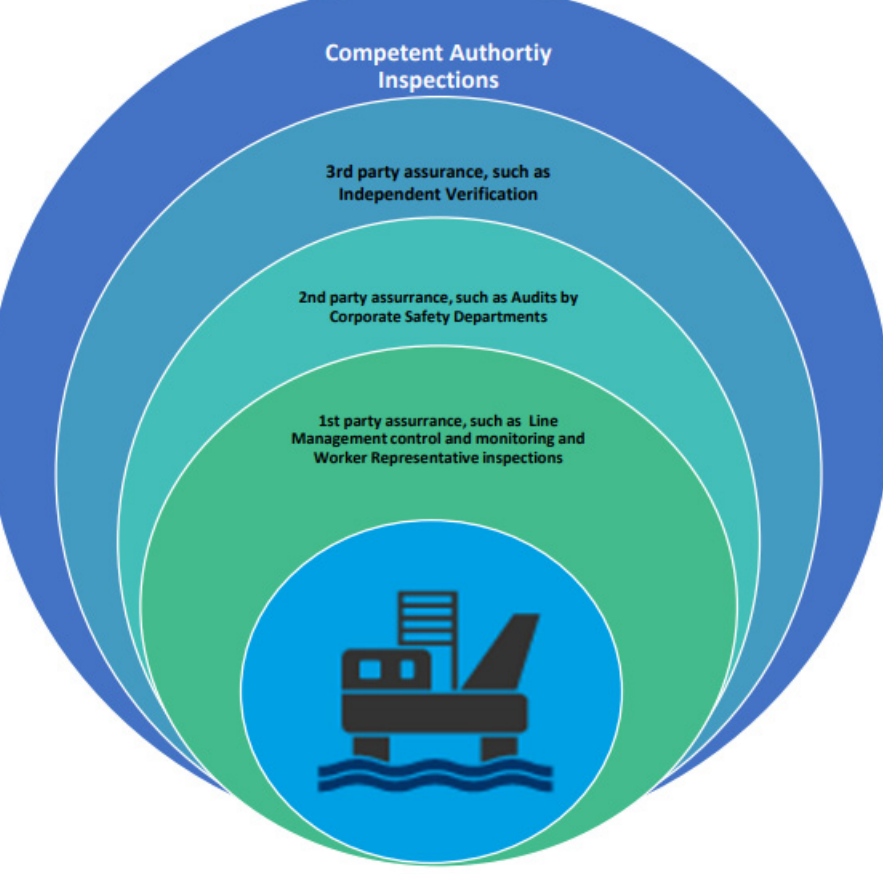
Figure 20. Assurance, monitoring, and assessment systems in the offshore oil & gas industry. (This image is re-used/reproduced with permission of the Health and Safety Executive under the terms of the Open Government License, Courtesy: HSE, UK.).